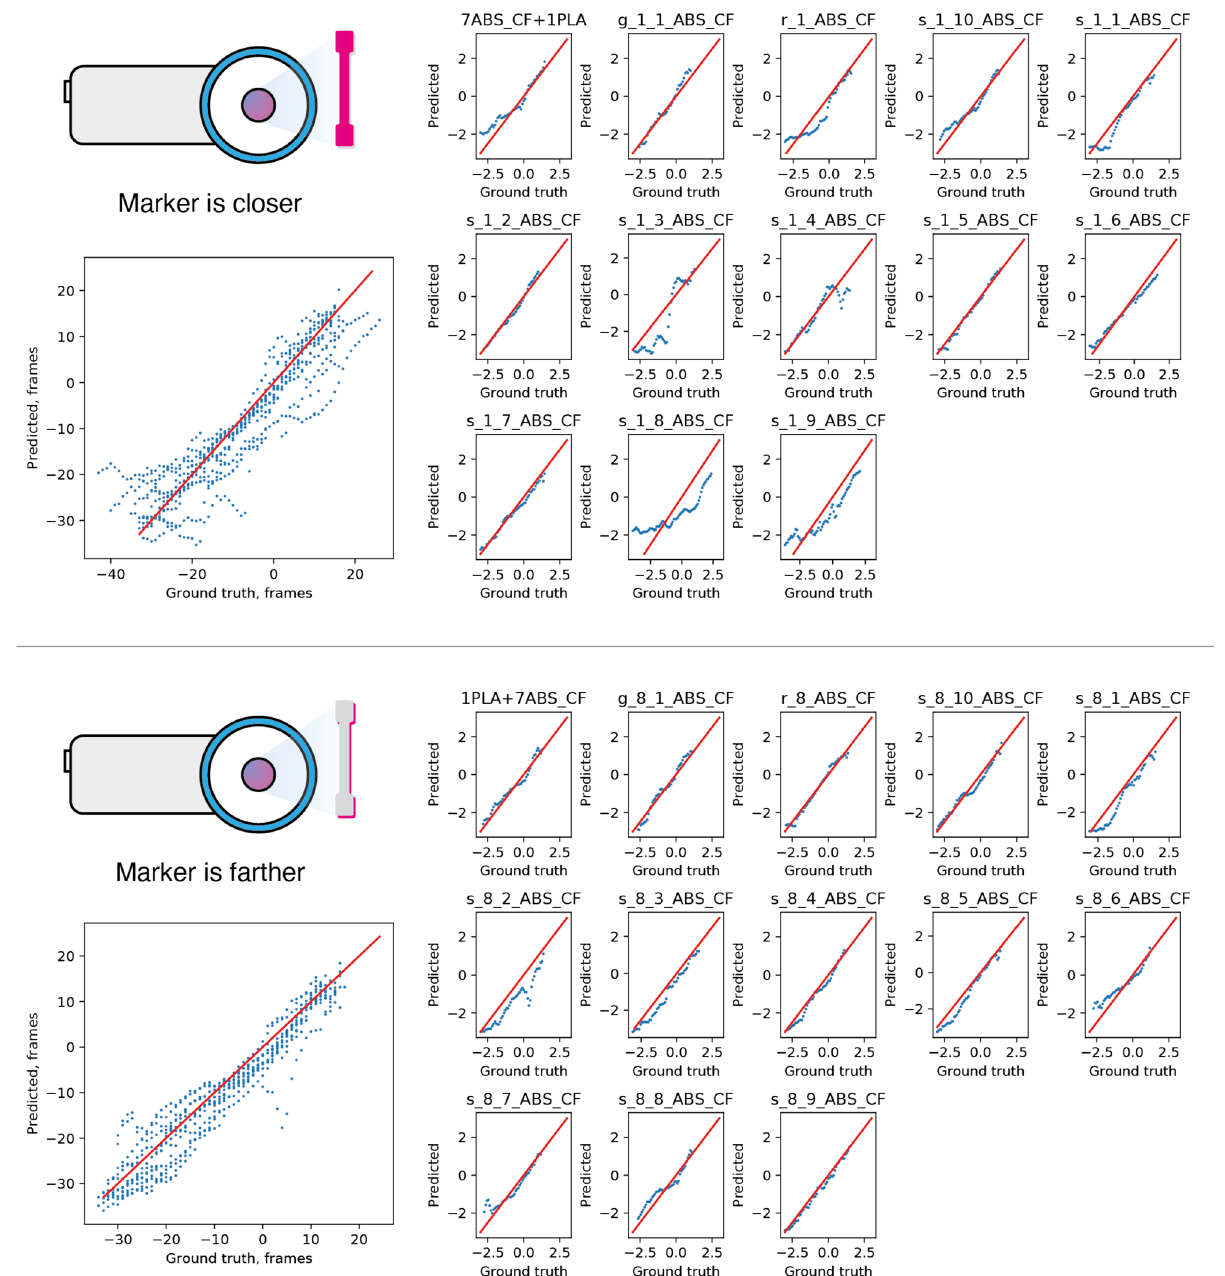
Figure 6. Results for different potential thermographic markers after neural network